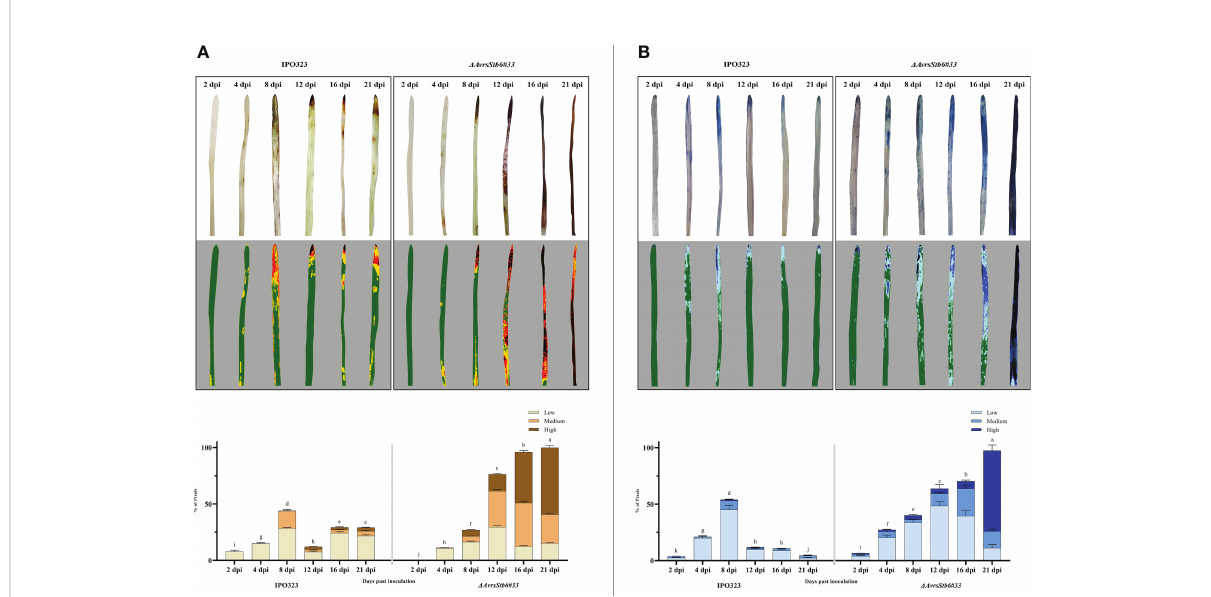
FIGURE 5 AvrStb6-Stb6 interaction affects both the accumulation of hydrogen peroxide (H 2 O 2 ) following staining by DAB signi fi ed by the red-brown areas (A) and the occurrence of cell death indicated as dark-blue areas stained by the trypan blue (B) . Pictures were taken at 2, 4, 8, 12, 16, and 21 dpi. The images were analyzed by the PlantCV software to obtain the integrated optical density (IOD), displaying the percentage of the stained cells by DAB and trypan blue. Data are indicate as mean ± SD (Standard Deviation) offour biological samples from three independent experiments. Different lowercase letters indicate statistically signi fi cant differences (P ≤ 0.05).